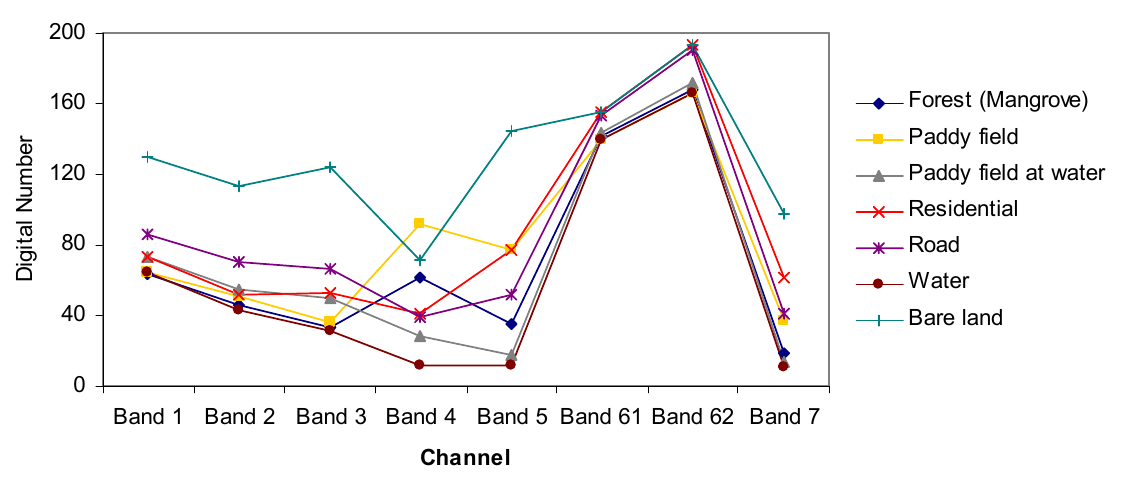
Figure 2. Spectral profiles for seven classes of land cover in Denpasar city. Values were derived from an average of 20 pixels for each class of land